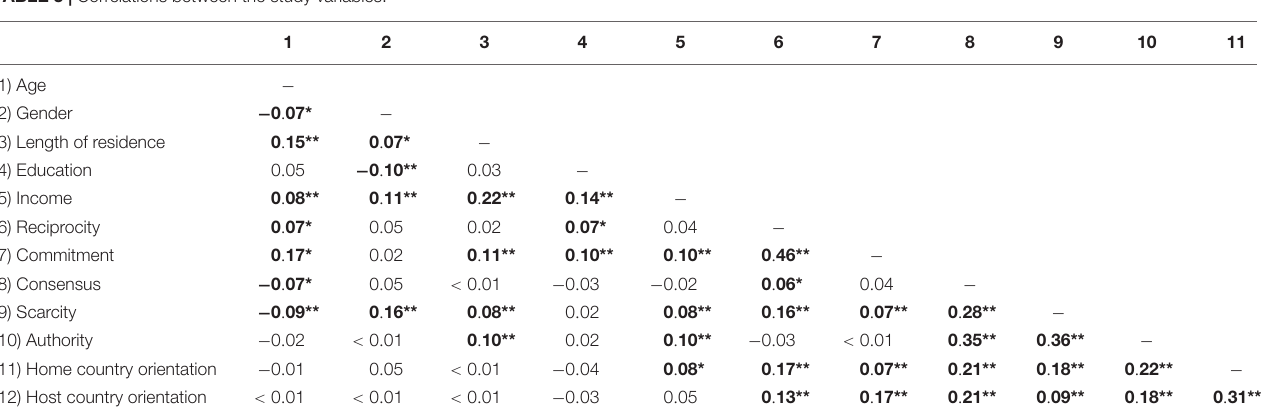
TABLE 3 | Correlations between the study